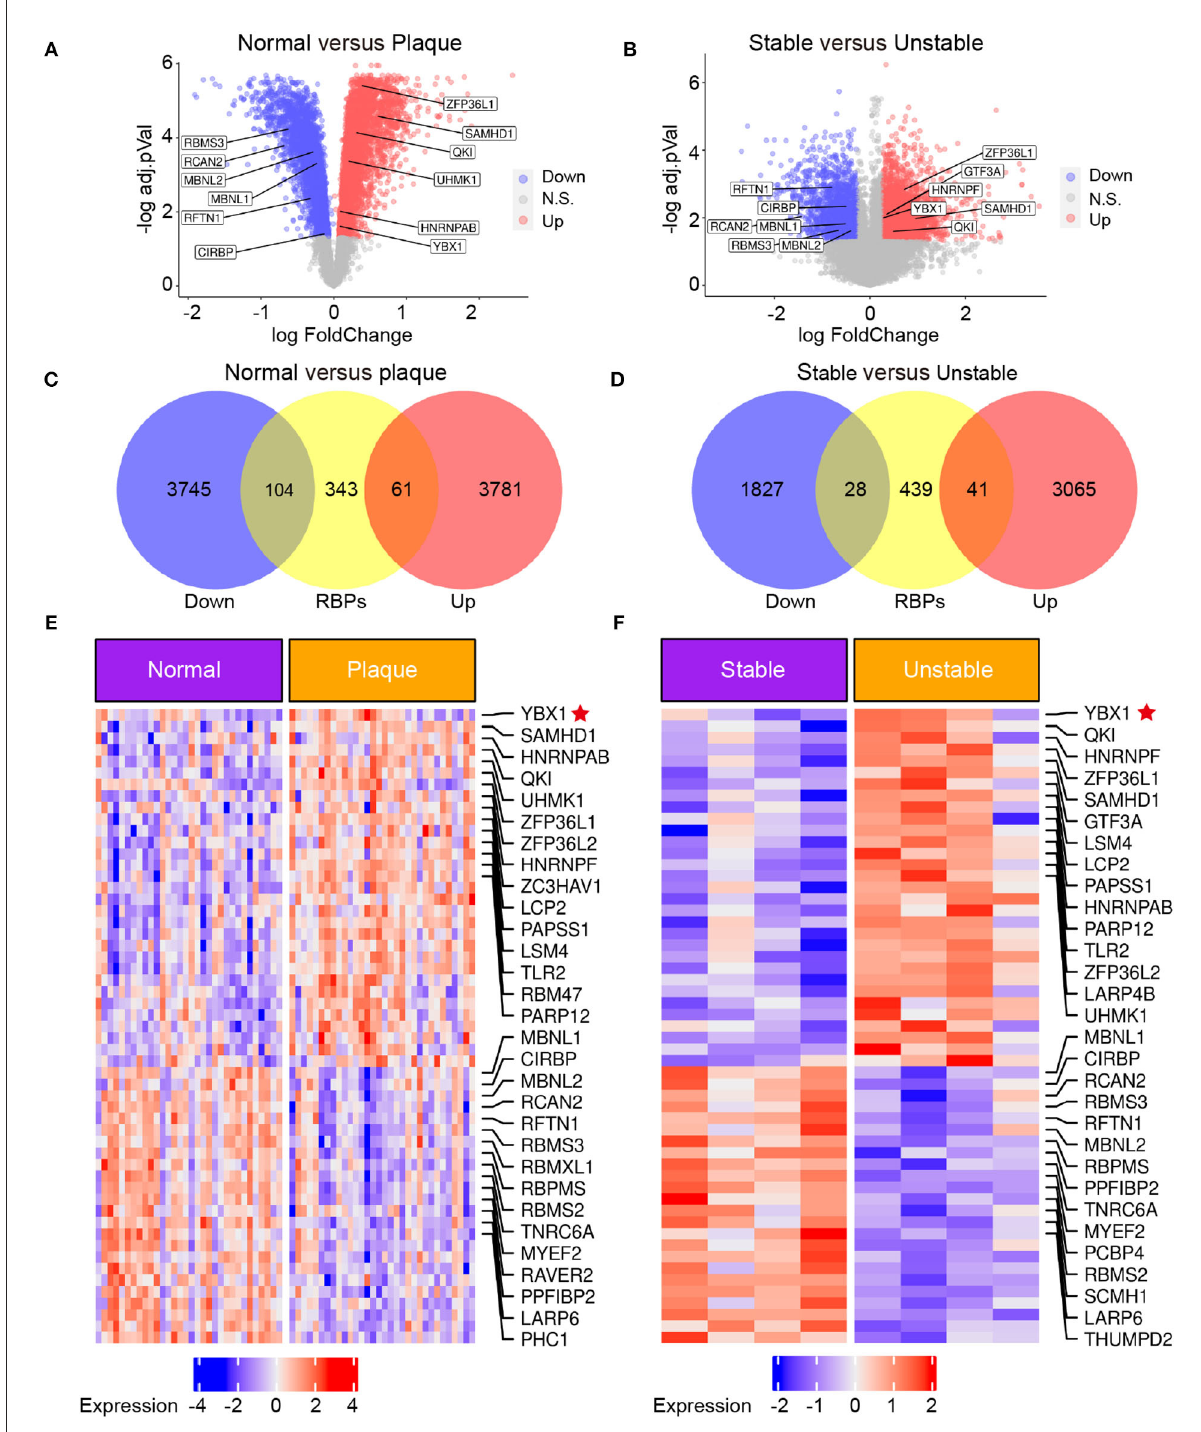
FIGURE1 The expression of YB1 was upregulated in patients with carotid atherosclerosis by transcriptomic profiling. (A,B) Volcano plot visualization of the differentially expressed genes (DEGs) between normal tissue and atherosclerotic plaque in patients with atherosclerosis [ (A) GSE43292, n = 32] and between stable and unstable plaque in patients with atherosclerosis [ (B) , GSE120521, n = 4], respectively. Red dots indicate upregulated genes in plaque, and blue dots indicate genes with decreased expression; (C,D) : Venn diagram indicating the upregulated and downregulated RBPs in the GSE43292 (C) and GSE120521 (D) datasets, respectively. (E,F) : Heatmap illustrates substantially upregulated RBPs in GSE43292 (E) and GSE120521 (F) datasets, respectively. The expression data was z-scores scaled by rows. Each row represented an RBP and was shown in descending order by average